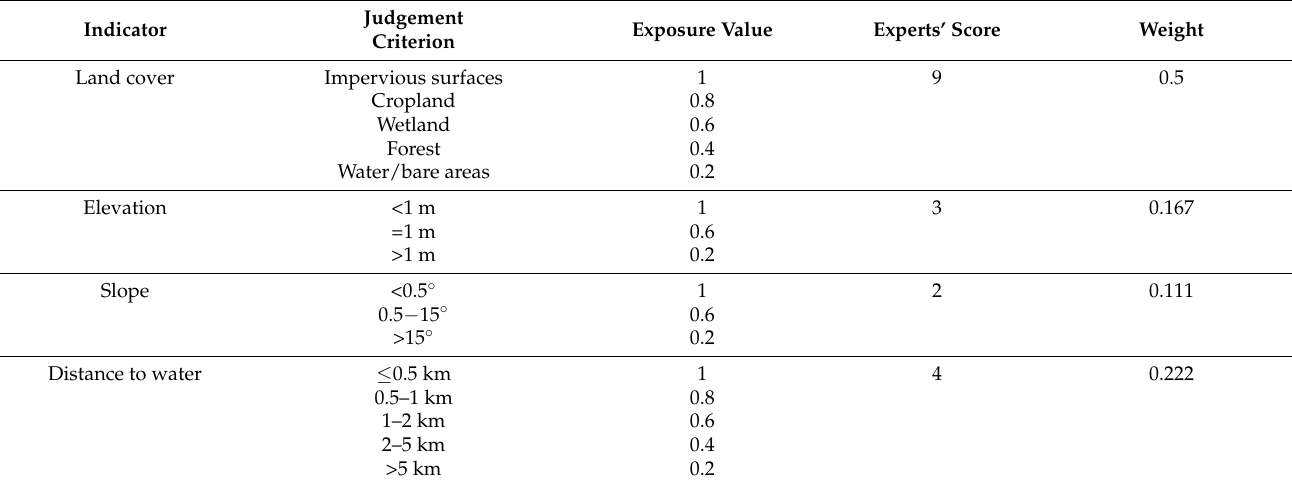
Table 2. Exposure index factor weight